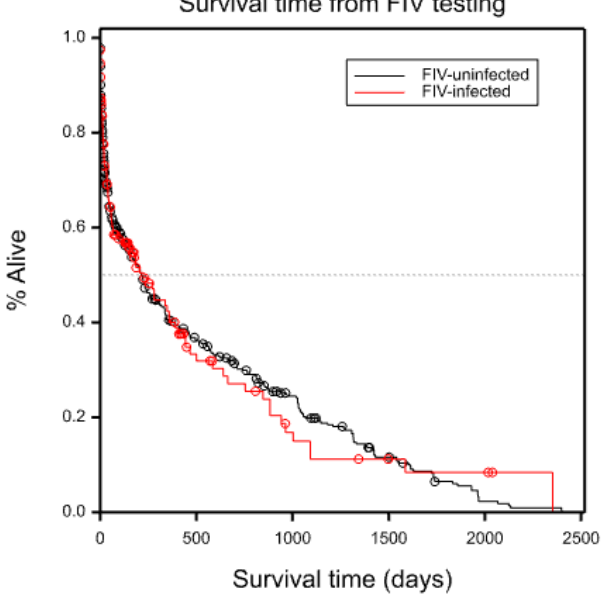
Figure 3. Kaplan–Meier survival analysis for cohorts 1 and 2 combined ( n = 734). No significant